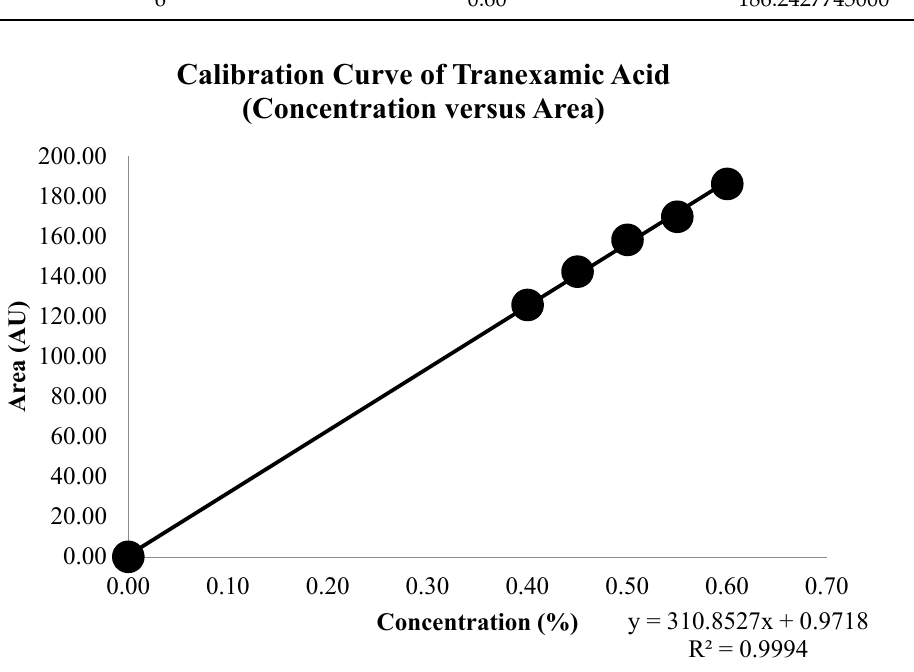
Figure 5. Calibration curve of tranexamic acid.